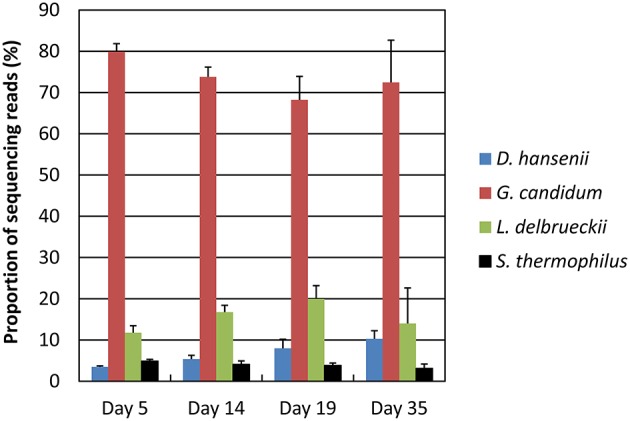
Distribution of the sequencing reads at the four sampling days. The RNA-seq data were normalized against the complete database. The upper error bars represent the standard deviations (three cheese replicates).